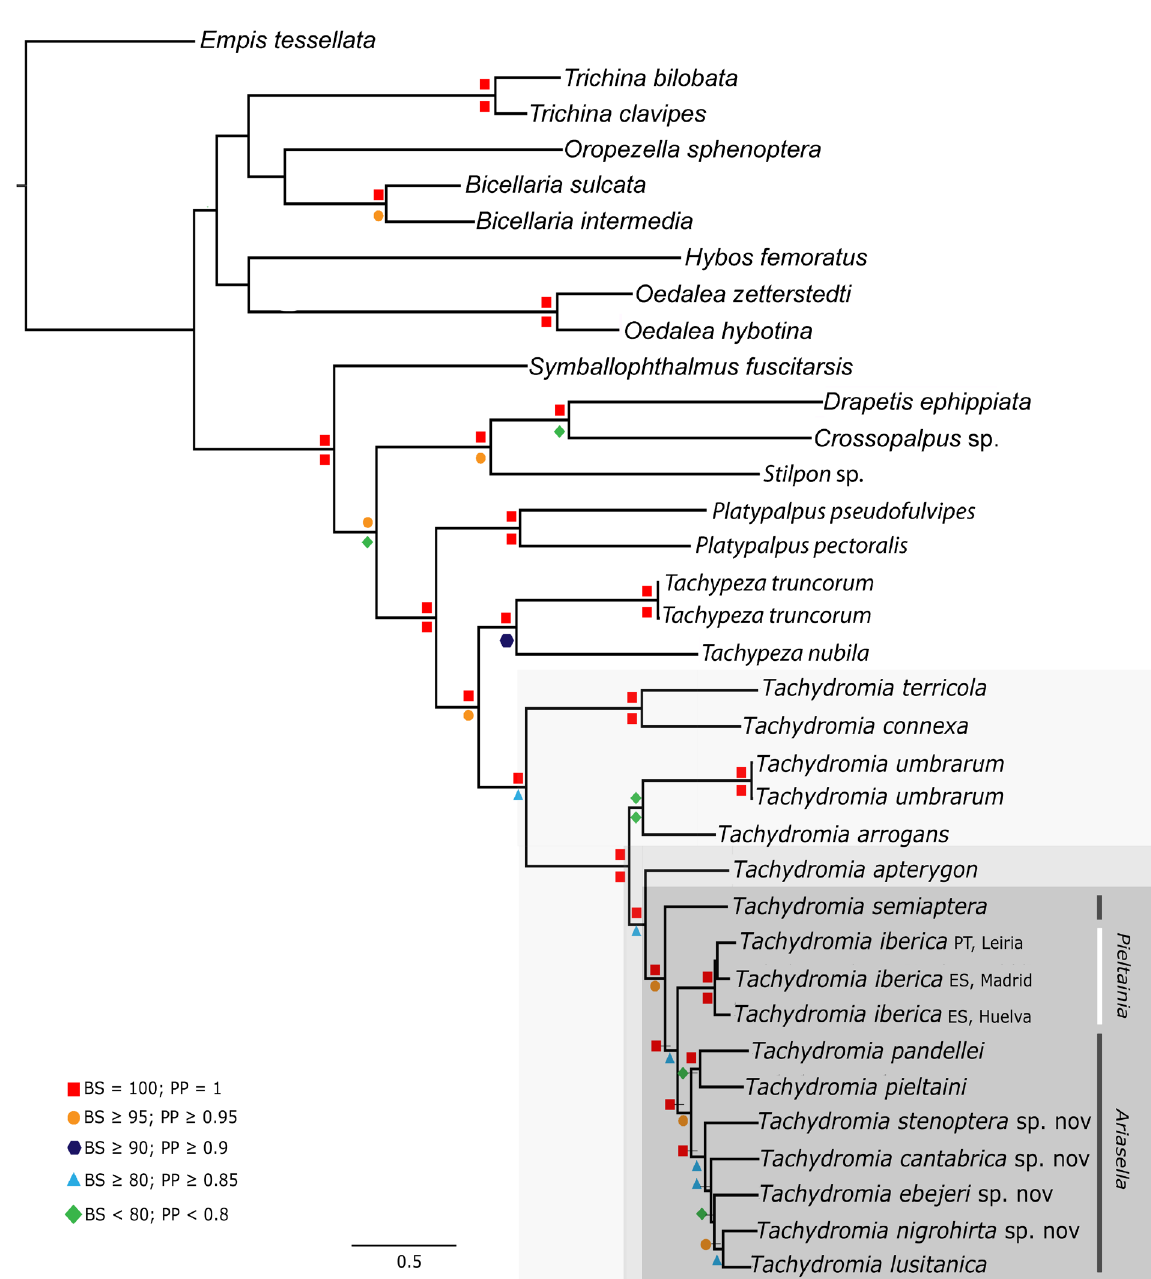
Fig. 2. Maximum-likelihood tree (ln L = -29397.646621) based on the combined dataset (COI, non- trimmed 28S,12S, AATS and PGD) using Garli ver. 2.01.1067 and the structural alignment for 28S. Bootstrap support values (below) and Bayesian posterior probabilities (above) are depicted at the nodes (only > 50 or > 0.5, respectively). Abbreviations: BS = Bootstrap support values; PP = Bayesian posterior probabilities. A greyscale is used to highlight the ingroup, where the darkest shade of grey highlights the Iberian flightless ant-like species of Tachydromia Meigen, 1803, followed by a lighter shade which includes T. apterygon Plant & Deeming, 2006, hence representing all the flightless species occurring in southern Europe and, finally, the lighter shade covers all Tachydromia analysed, including the macropterous species assigned to different species groups sensu Chvála (1970). The white bar indicates the species originally assigned to genus Pieltainia Arias, 1919, while the grey bars indicate the taxa originally assigned to genus different species-groups sensu